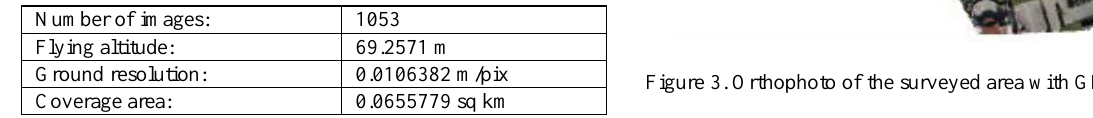
Table 2. Flight specifications